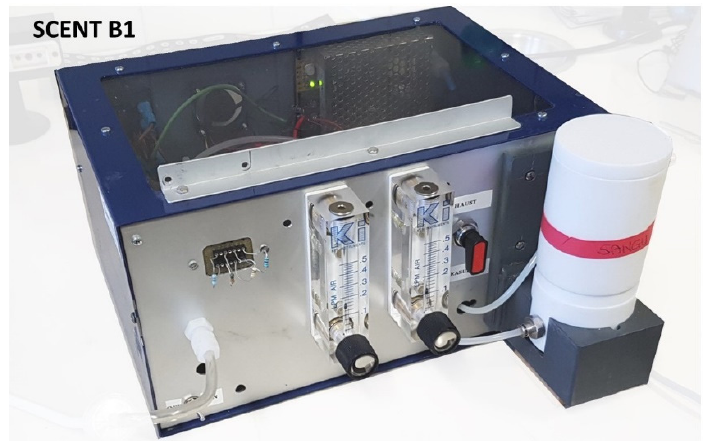
Figure 7. SCENT B1 device.